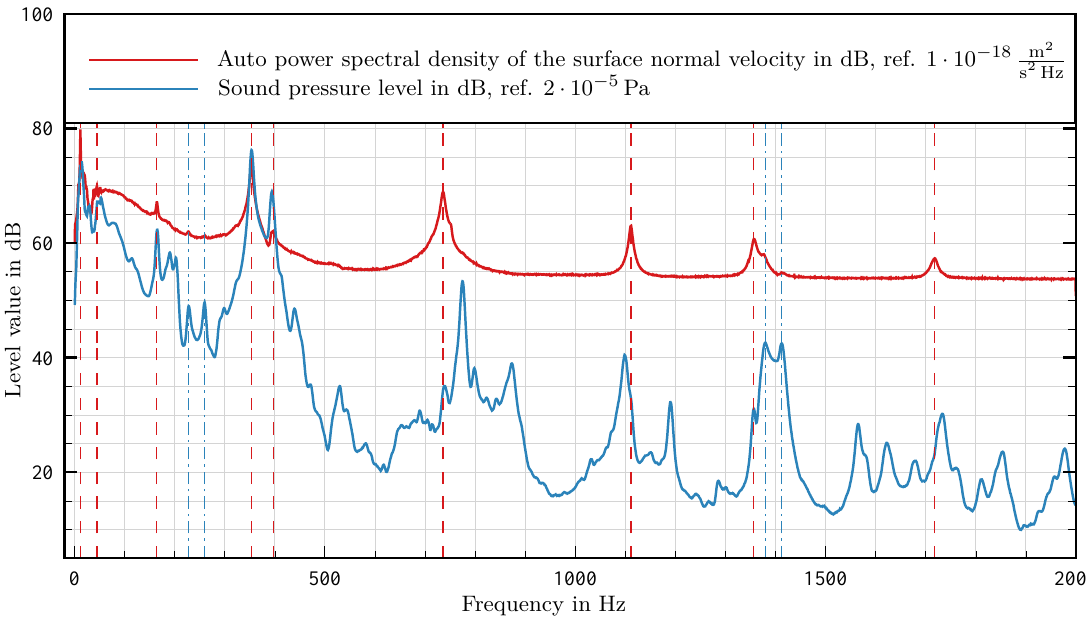
Figure 14. Comparison between structural vibration and sound